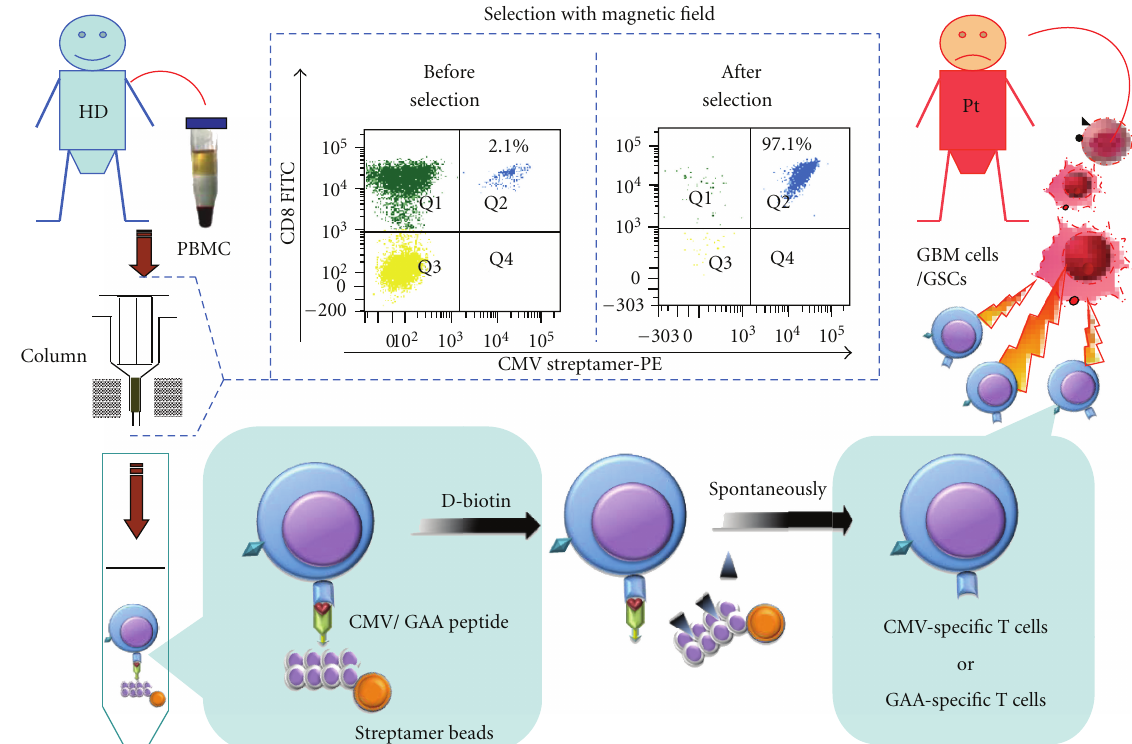
Figure 2: Adoptive immunotherapy for GBM patients with CMV or GAA peptides. CMV and GAAs are highly expressed in GBM, but neither in healthy brain tissue, nor in nonmalignant brain tumors. Therefore, GAAs constitute good targets for immunotherapy of GBM patients. The streptamer technology o ff ers the advantage of selecting CMV- or GAA-specific CD8 + CTLs at the good manufacturing practice (GMP) level in vitro . PBMCs from healthy donors are collected and isolated by streptamer beads. Noninduced antigen-specific T cells are purified and accumulated through a magnetic field and released by D-biotin from the streptamer complex. Subsequently, these cells are administered to the GBM patient. CMV/GAA-specific cytotoxic T cells can recognize the target antigens which are presented on the surface of GBM cells or GSCs. Cytotoxicity is exerted directly through the Fas or perforin pathway and/or indirectly by the release of cytokines. CMV: cytomegalovirus; GAA: glioblastoma associated antigen; GBM: glioblastoma multiforme; GSCs: glioblastoma stem cells; HD: healthy donor; PBMC: peripheral blood mononuclear cells; Pt: patient.